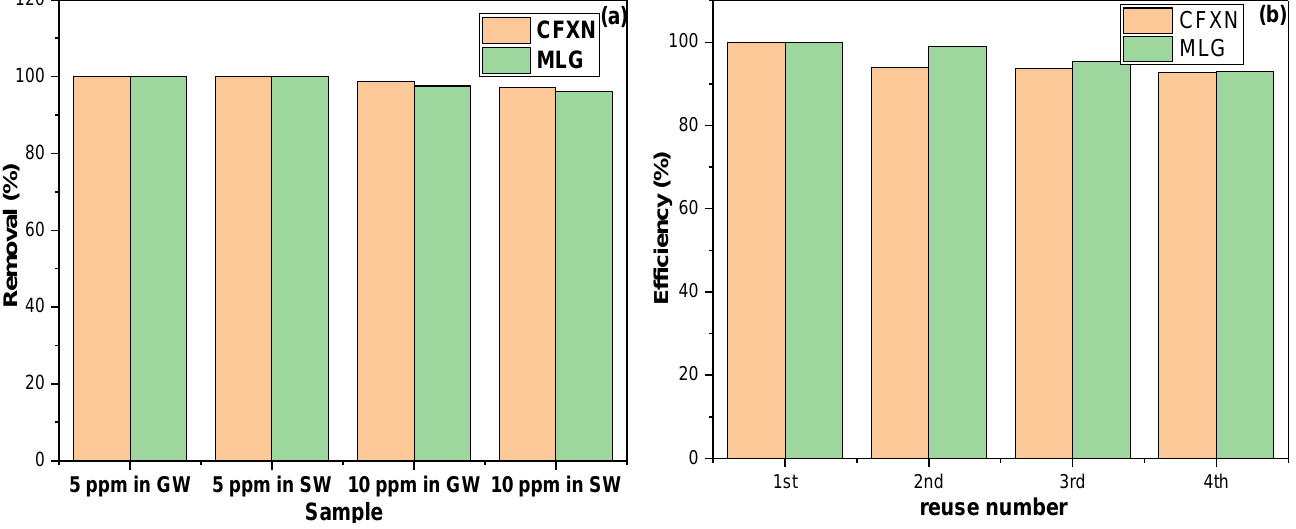
Figure 9. ( a ) The removal efficiency of CFXN and MLG from SW and GW samples with the prepared CNPs; ( b ) the reuse performance of the prepared CNPs in removing CFXN and MLG from aqueous solutions.